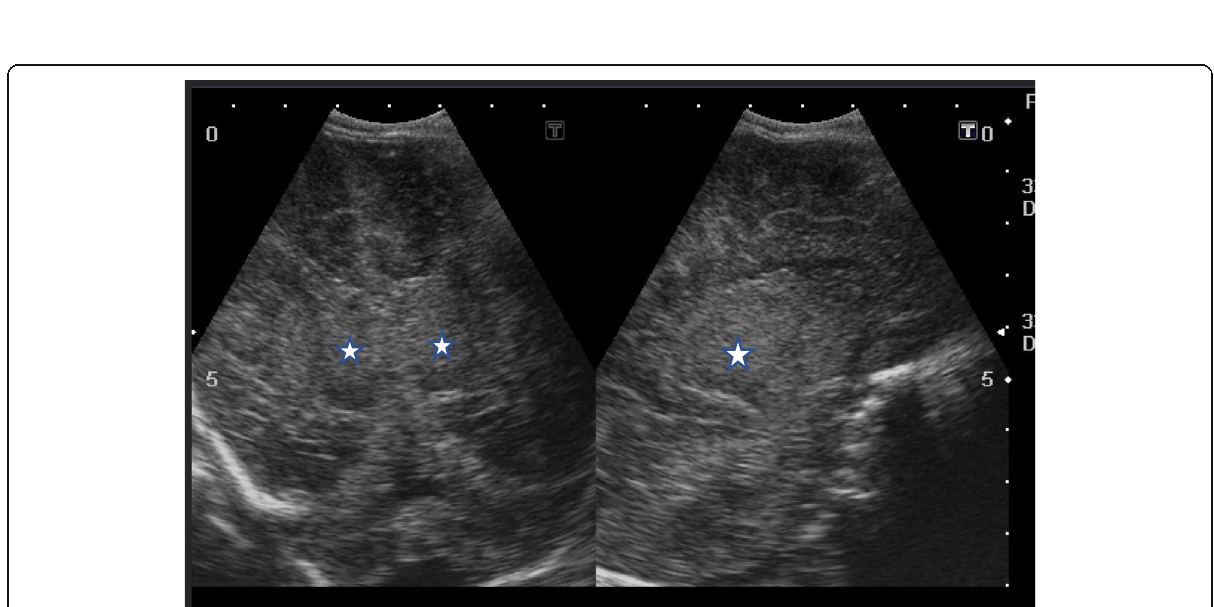
Fig. 7 Coronal and sagittal US image of a neonate with Sarnat stage III showing severe hypoxic ischemic insult in terms of cerebral cortex and bilateral thalamic (white stars) and basal ganglia diffuse increased echogenicity with marked edema and compressed